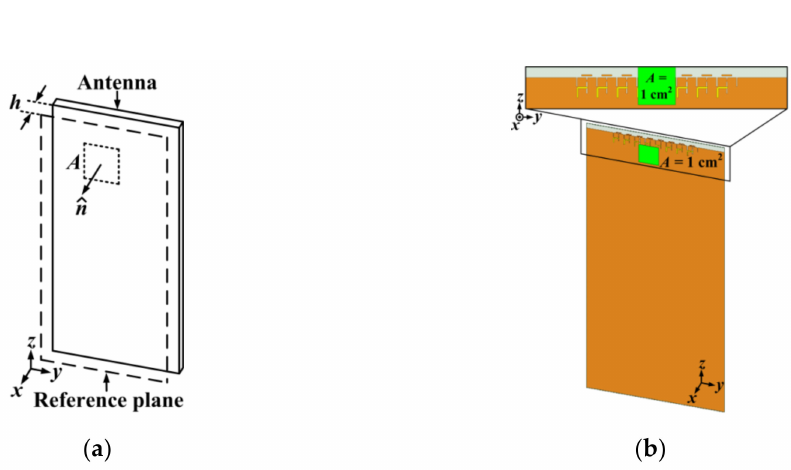
Figure 14. Simulation of the power density: ( a ) simulation setup, and ( b ) power density simulation of the proposed 1 × 8 array